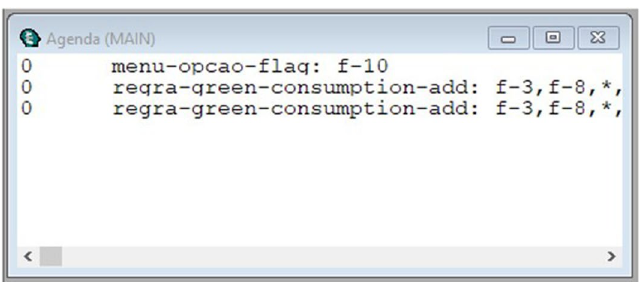
Fig. 6 Example of three active rules in the CLIPS schedule